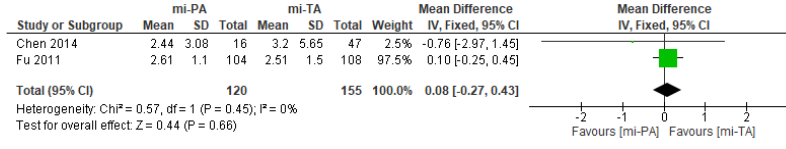
success, ( e ) no ‐ standardized absent clinical success, ( f ) postoperative SBP, ( g ) postoperative DBP,